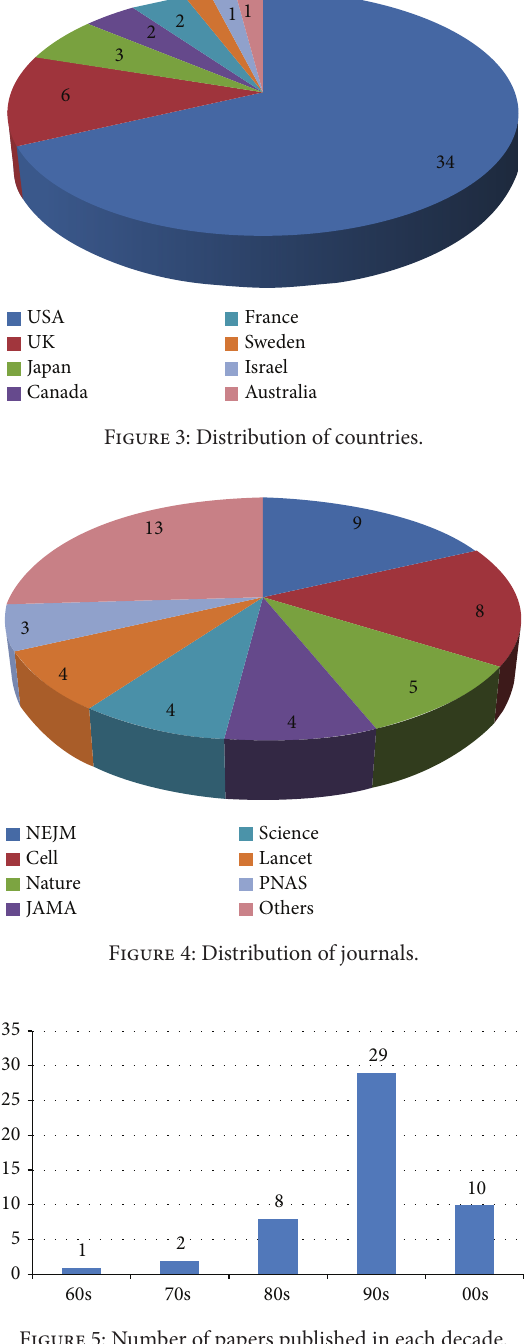
keywords. All keywords were found, but some papers did not reach enough citations to be put onto the list of the Top